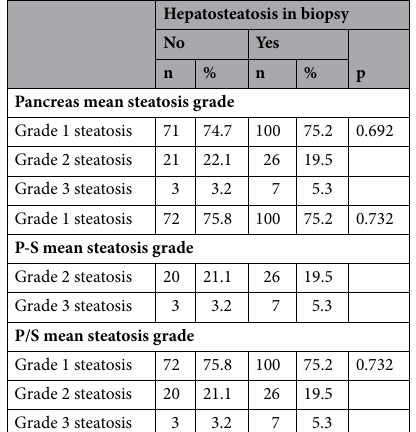
Table 5. The relationship between HS in biopsy and pancreatic steatosis in CT scan.